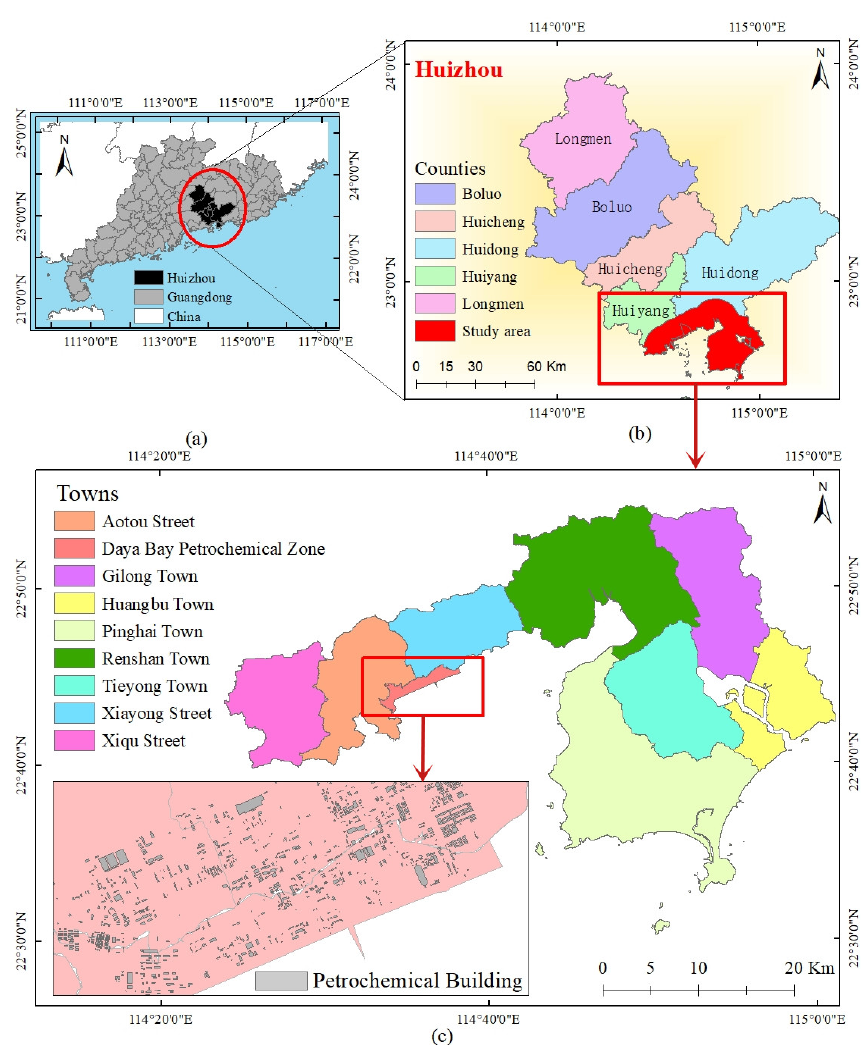
Figure 1. The maps of observation locations used in the study: (a) the map of Guangdong Province in the southern area of China where the shapefile of administrative boundaries was obtained from the GADM database under © 2018 GADM license (https://gadm.org/data.html, last access: 19 January 2021), with academic publishing permission from Global Administrative Areas (https://gadm.org/license.html, last access: 19 January 2021); (b) the map of Huizhou city and the study area, which was made using the ArcGIS 10.5; (c) the map of towns and their boundaries in the study area and the petrochemical buildings are distributed in the Daya Bay Petrochemical Zone, which was made using the ArcGIS 10.5. The maps and satellite images obtained from © Google Earth or © Google Maps can be used and printed in the research papers with permission from Google’s website (https://www.google.com/permissions/geoguidelines/, last access: 19 January